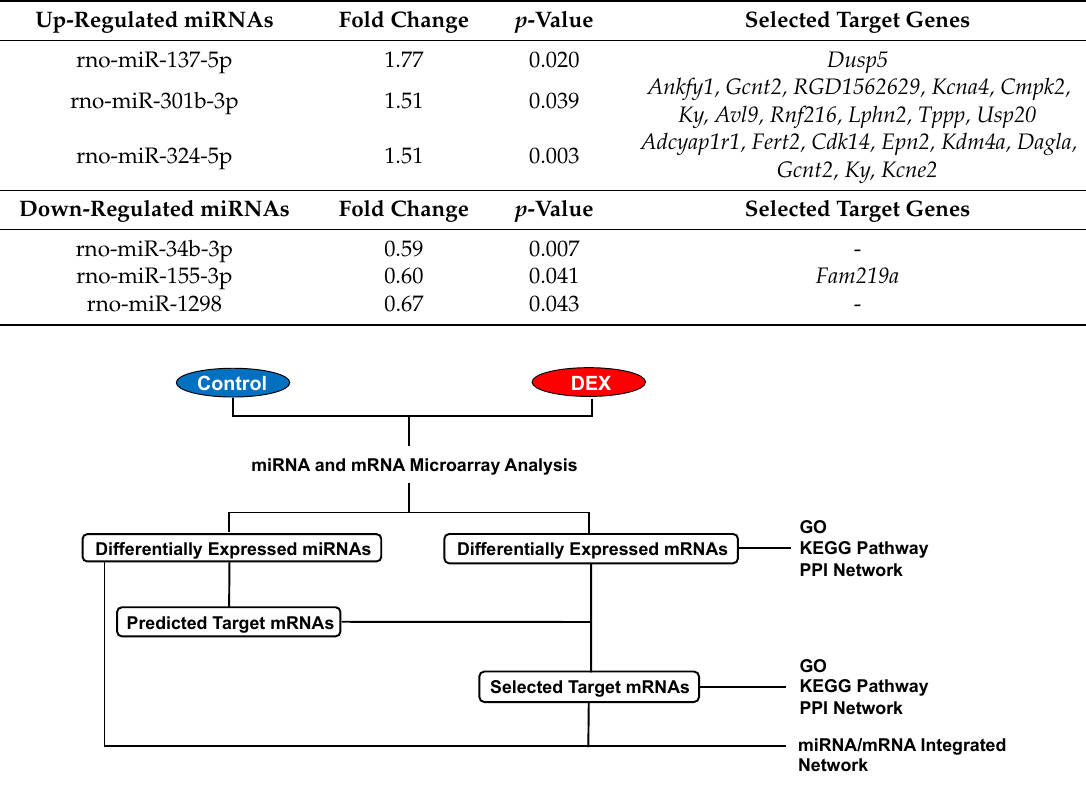
Figure 3. Multi-step approach for analysis of the differentially expressed mRNAs and miRNAs. DEX: dexmedetomidine, GO: gene ontology, KEGG: Kyoto Encyclopedia of Genes and Genomes, PPI: protein-protein interaction.